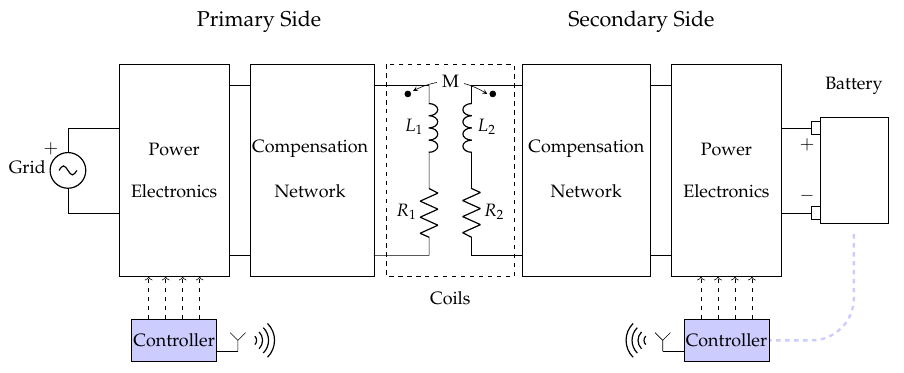
Figure 3. The generic structure of an EV wireless charger.